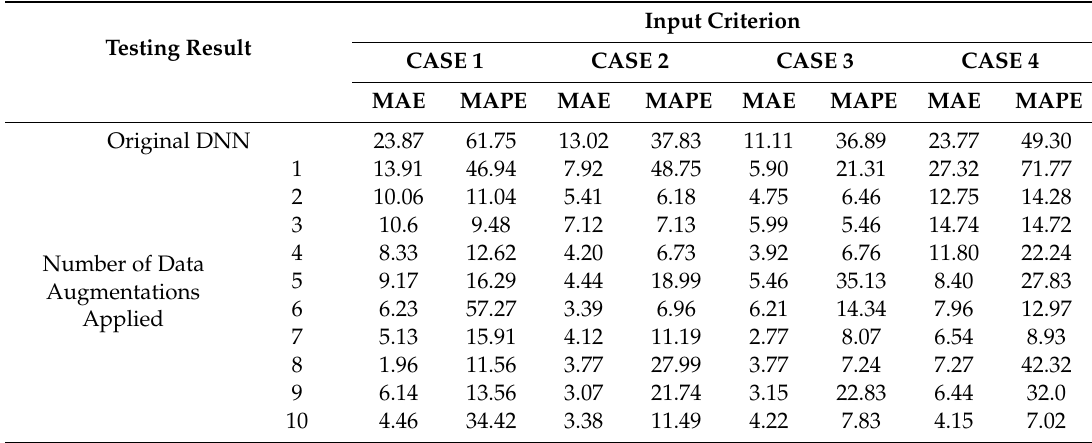
Table 7. Testing error with data